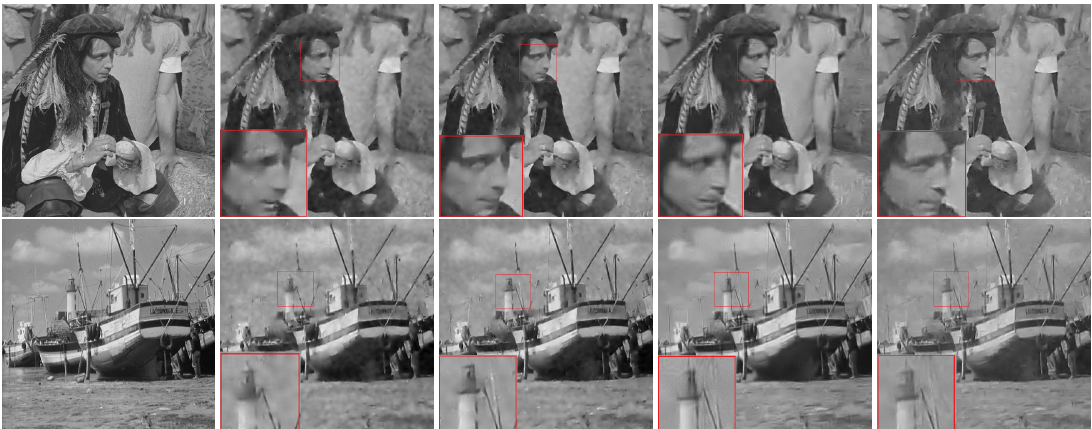
Figure 7. Visual comparison of reconstruction results by different methods on ‘Man’ and ‘Boat’. From left to right: original, T.KSVD [3], K-SVD [14], DFT [33], and